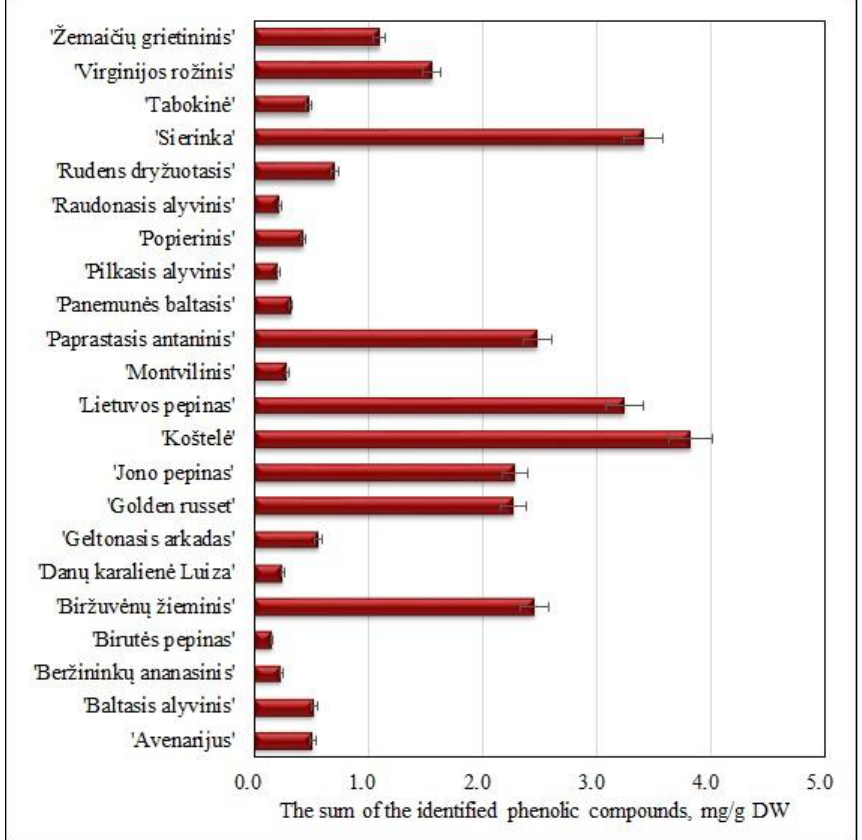
Figure 1 Figure 1. Variability of the sum of the identified phenolic compounds in fruit samples of heirloom apple